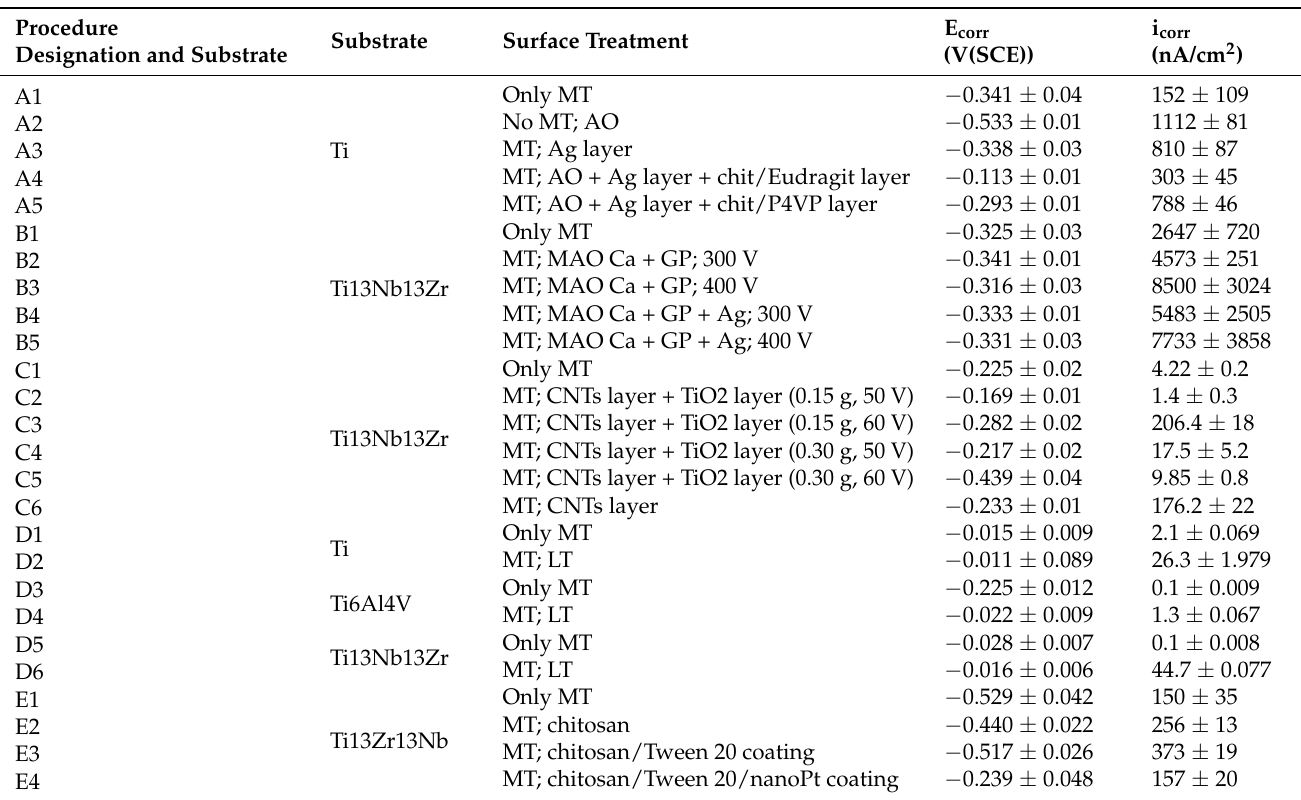
Table 4. Results of corrosion tests.